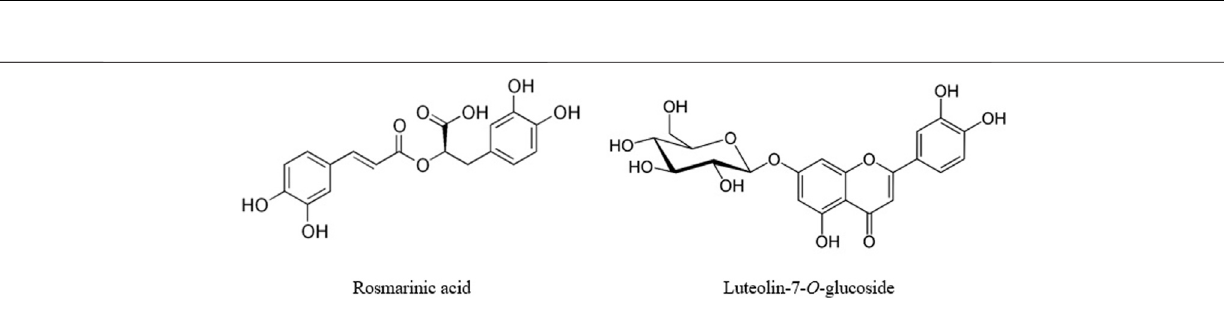
FIGURE2| HPLCchromatogramofpolyphenolsintheMFDE.1,neochlorogenicacid;2,chlorogenicacid;3,caffeicacid;4,luteolin-7- O -glucoside;5,apigenin-7- O -glucoside; 6, rosmarinic acid; 7, acacetin-7- O -glucoside; 8, luteolin; 9, apigenin.